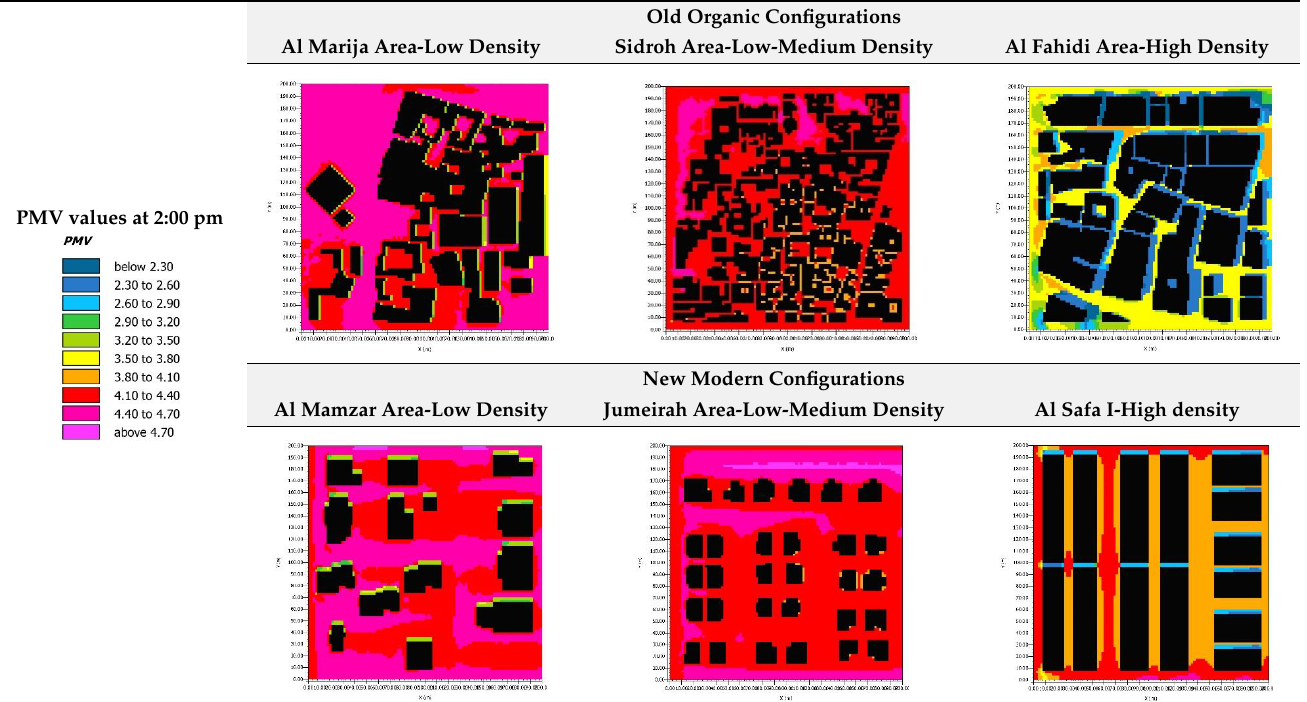
Table 9. ENVI-met maps of the PMV values for Al Marija, Sidroh, Al Fahidi, Al Mamzar, Jumeirah, and Al Safa I in April at 2:00 pm (Images generated by ENVI-met).